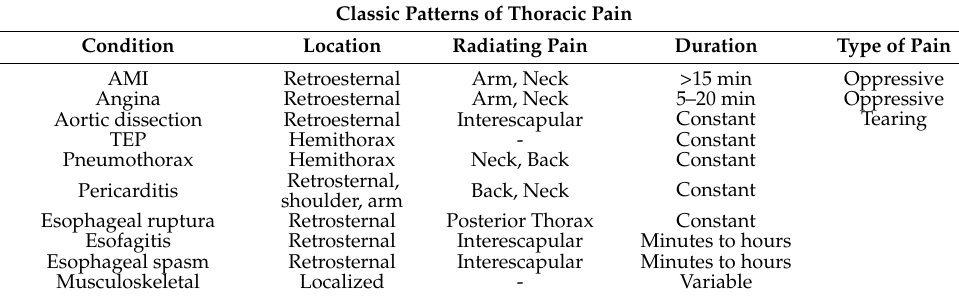
Table 1. Assessment criteria used for